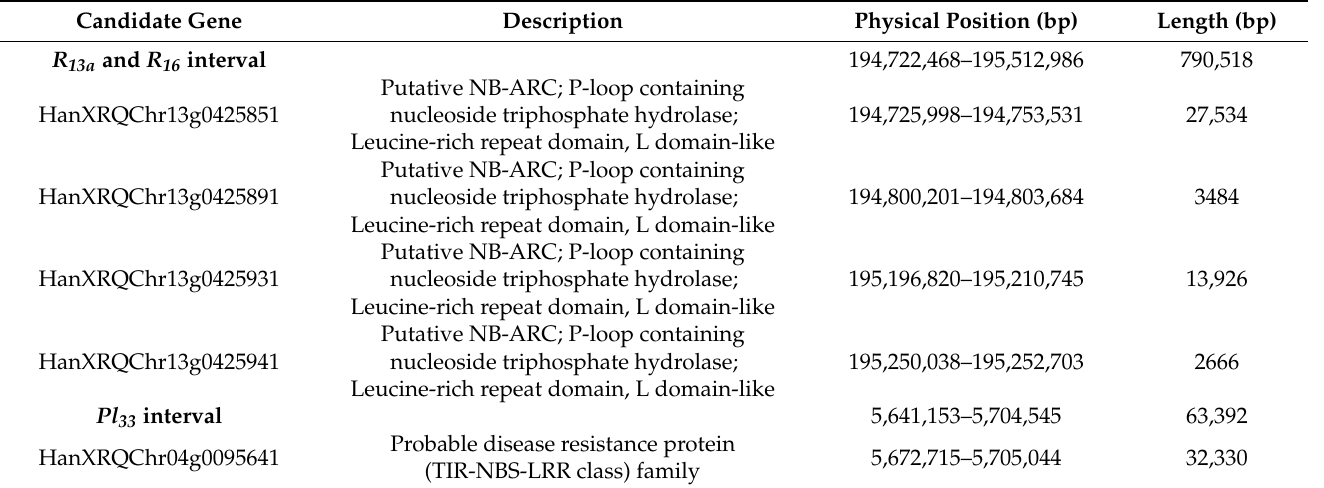
Table 6. Predicted plant disease defense-related genes in the interval of R 13a , R 16 , and Pl 33 in the XRQr1.0 genome assembly.